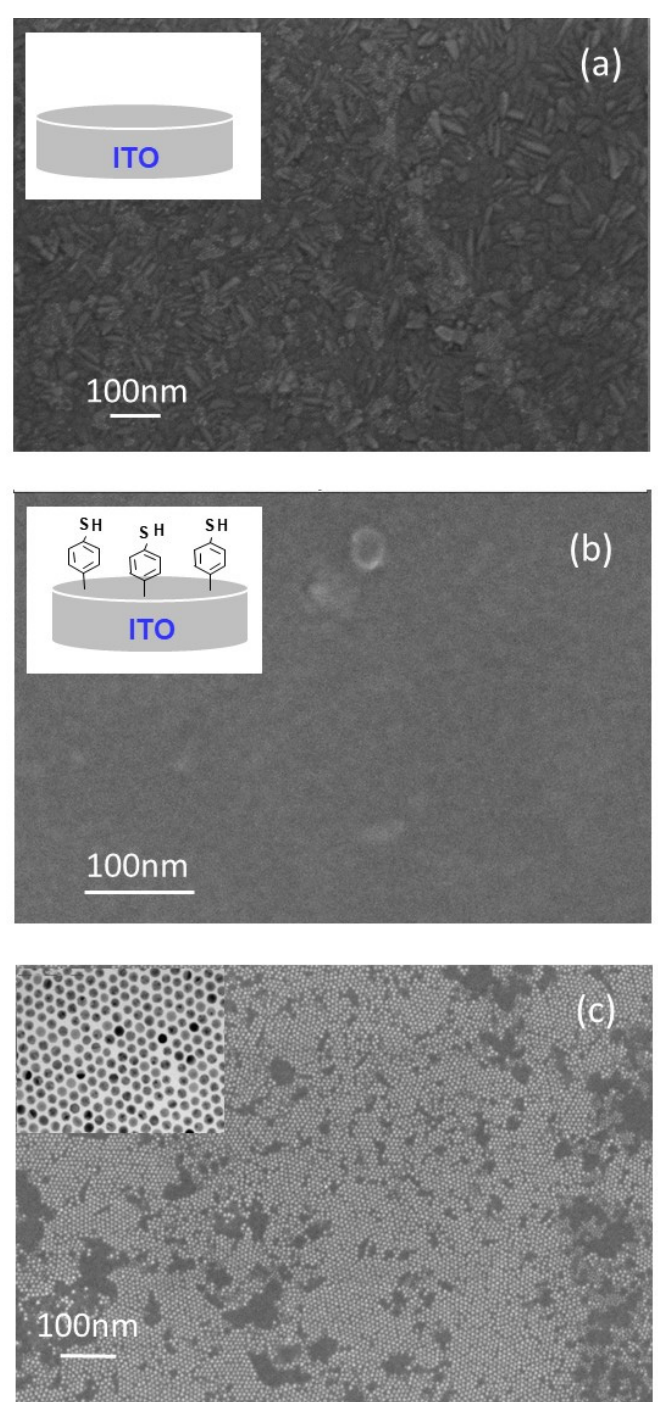
Figure 3. Field Emission Gun Scanning Electron Microscopy (FEG-SEM) images of ( a ) bare indium tin oxide ITO, ( b ) modified ITO electrode by 4-thiolphenyl using the electroreduction method and ( c ) modified ITO electrode with AuNP. The insert is the Transmission Electron Microscopy (TEM) pattern of AuNPs.